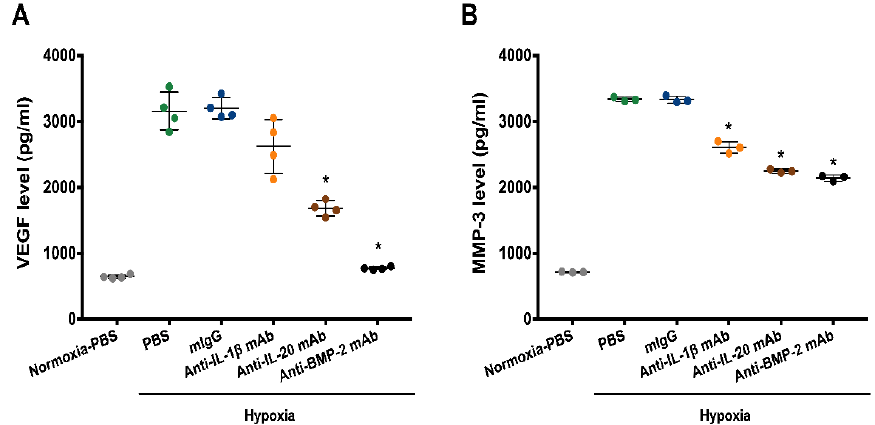
Figure 4. MMP-3 and VEGF levels in anti-IL-1 β , -IL-20, and -BMP-2 mAb-treated IVD cells. IVD cells treated with antibodies against IL-1 β , IL-20, and BMP-2 under hypoxia. Primary cultured IVD cells were exposed to PBS, mIgG (2 µ g / mL), IL-1 β antibody (2 µ g / mL), IL-20 antibody (2 µ g / mL), and BMP-2 antibody (2 µ g / mL) under hypoxic conditions for 24 h ( n = 4 / group). ( A , B ) The conditioned medium was then collected and analyzed using MMP-3 and VEGF enzyme-linked immunosorbent assay (ELISA) kits. Dots on the bar chart indicated the triplicates or quadruplicates for each group. * p < 0.05 compared with mIgG-treated controls. Data are expressed as mean ± SD. The experiment was repeated twice with similar results.